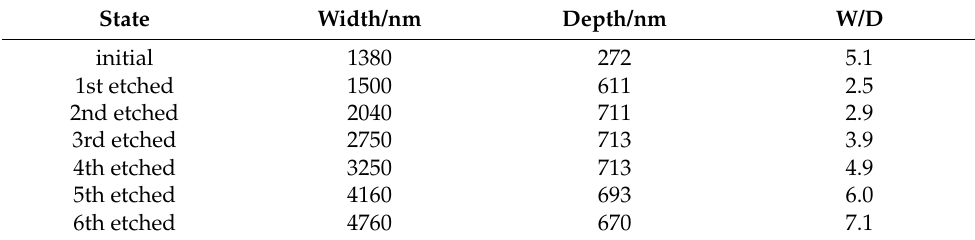
Table 2. Profile data during HF etching of the left pit in Zone D.